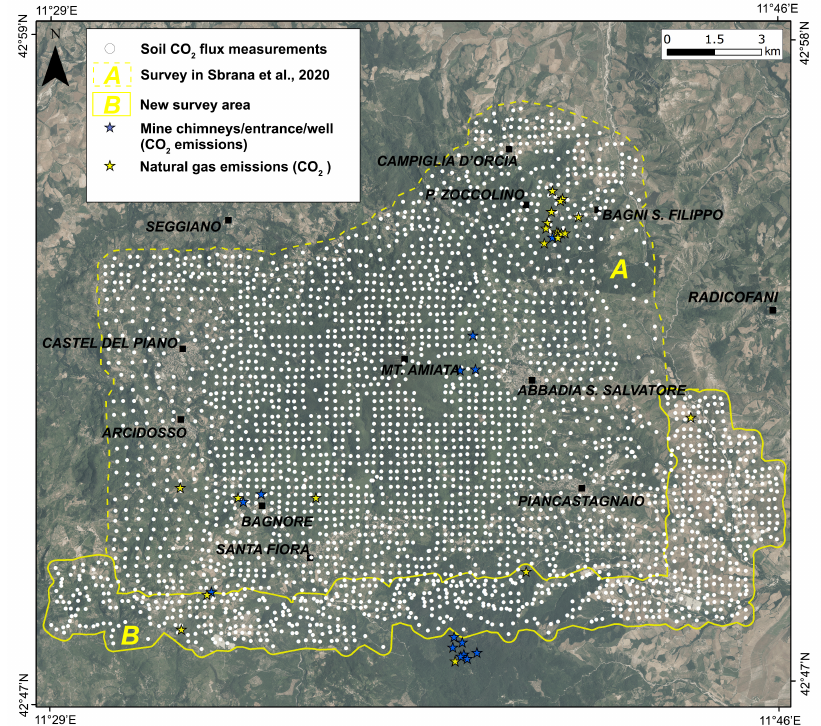
Figure 2. Measurement points for the first A and second B